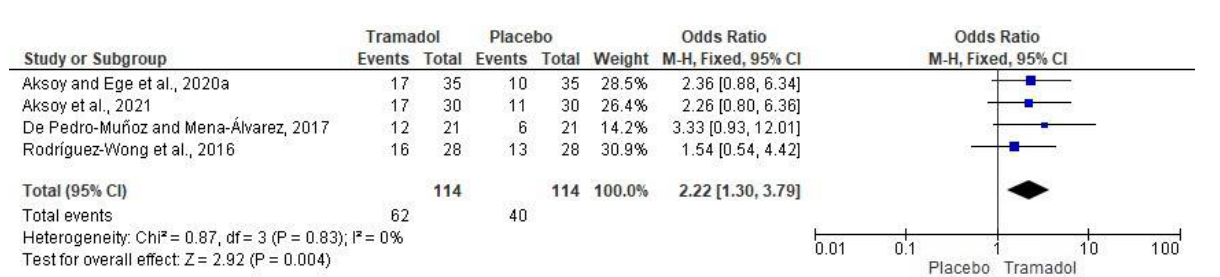
Figure 3. Forest plot of the effect of local tramadol versus placebo/local anesthetics on anesthetic success.